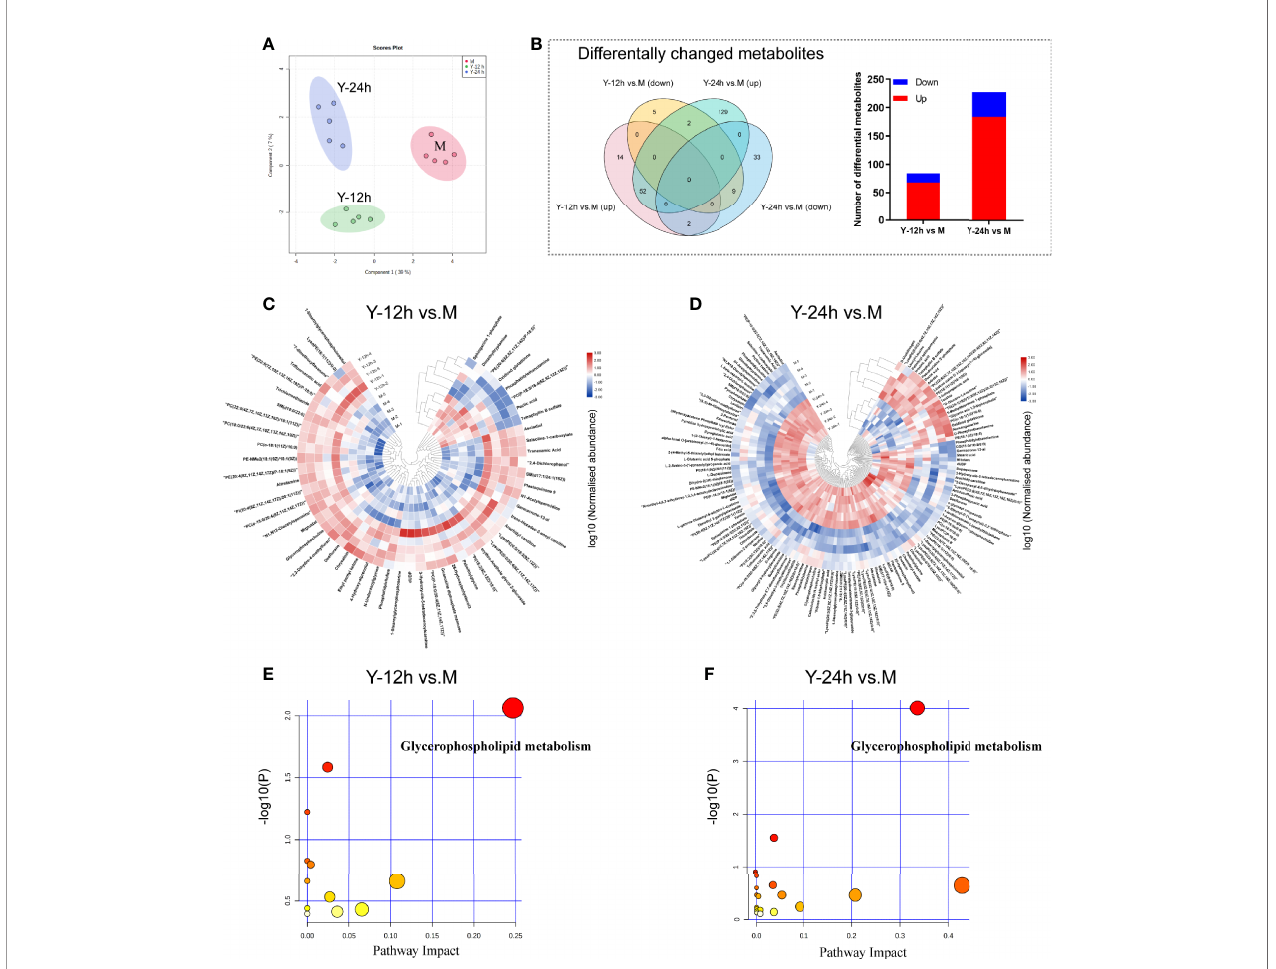
FIGURE 3 | Data-dependent metabonomic analyses. (A) PCA of unstimulated monocytes (M) and monocytes stimulated with heat-killed C. albicans for 12 h (Y-12 h) and 24 h (Y-24 h) (n = 5). (B) Venn diagrams depict the differential metabolites of monocytes after 12 h and 24 h stimulation by heat-killed C. albicans versus M group. Bar graphs show the number of up- (red) and down-regulated (blue) metabolites. (C, D) Hierarchical clustering analysis of differential metabolites between monocytes stimulated by heat-killed C. albicans and the M group. Normalized abundance of metabolites was logarithmic transformed. (E, F) Pathway analysis of the differential metabolites in monocytes stimulated by C. albicans . The following criteria were used to identify relevant pathways: y axis, enrichment signi fi cance ( P < 0.05, [log ( P ) > 1.3]) and x axis, pathway impact (> 0.2) for network